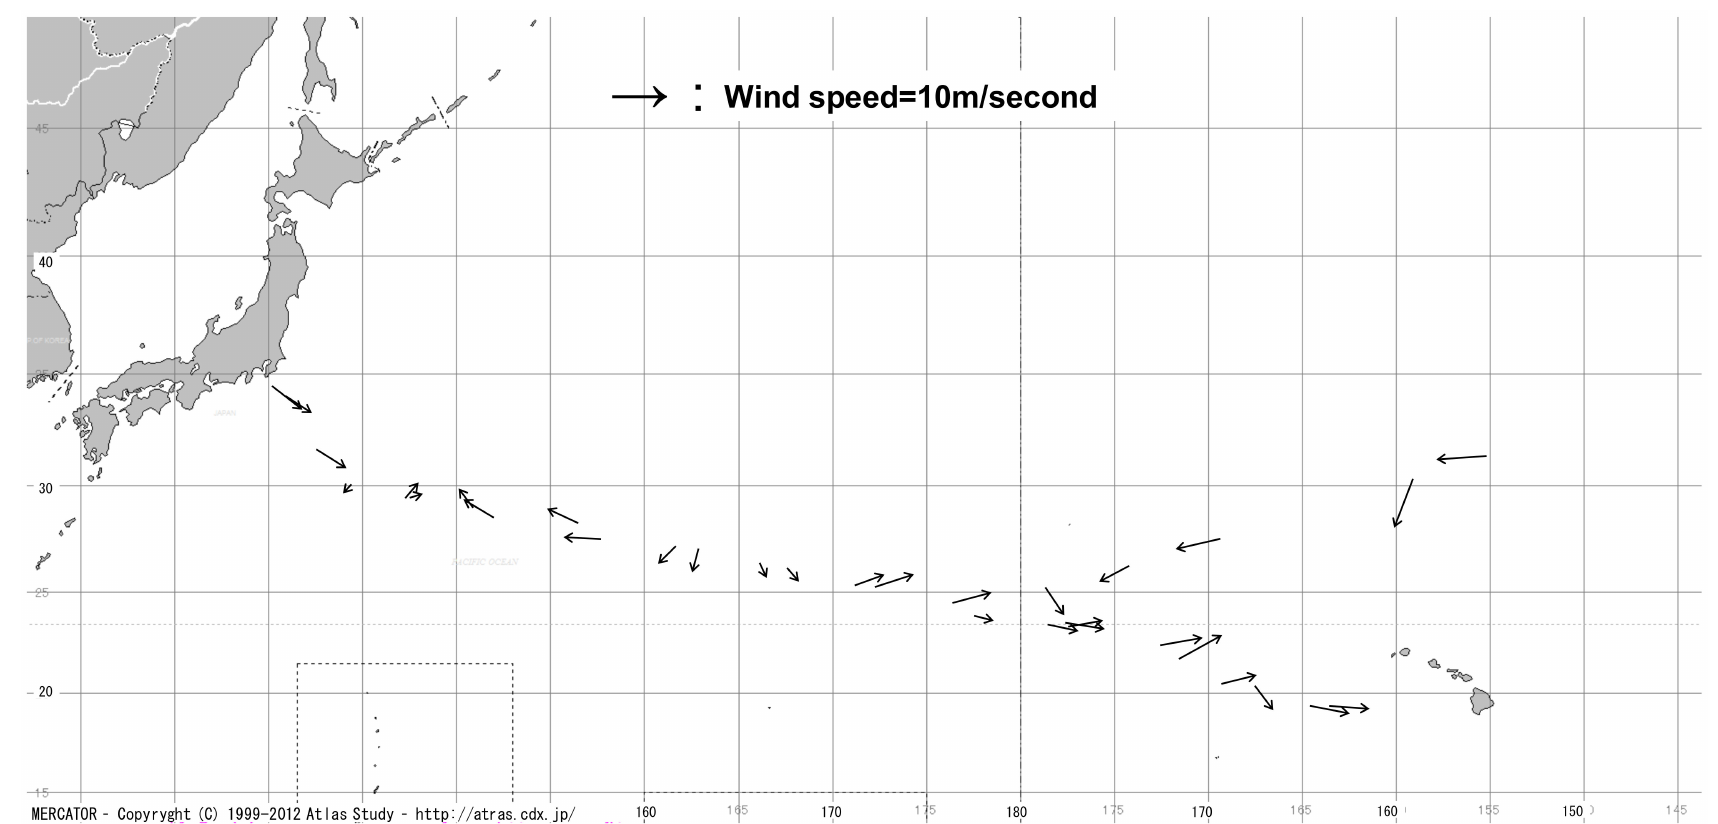
Figure 2. Schematic representation of the cruise routes (KH-10-04 and KH-12-02) by the RV Hakuho Maru. Arrows show the wind direction and wind speed at each sampling